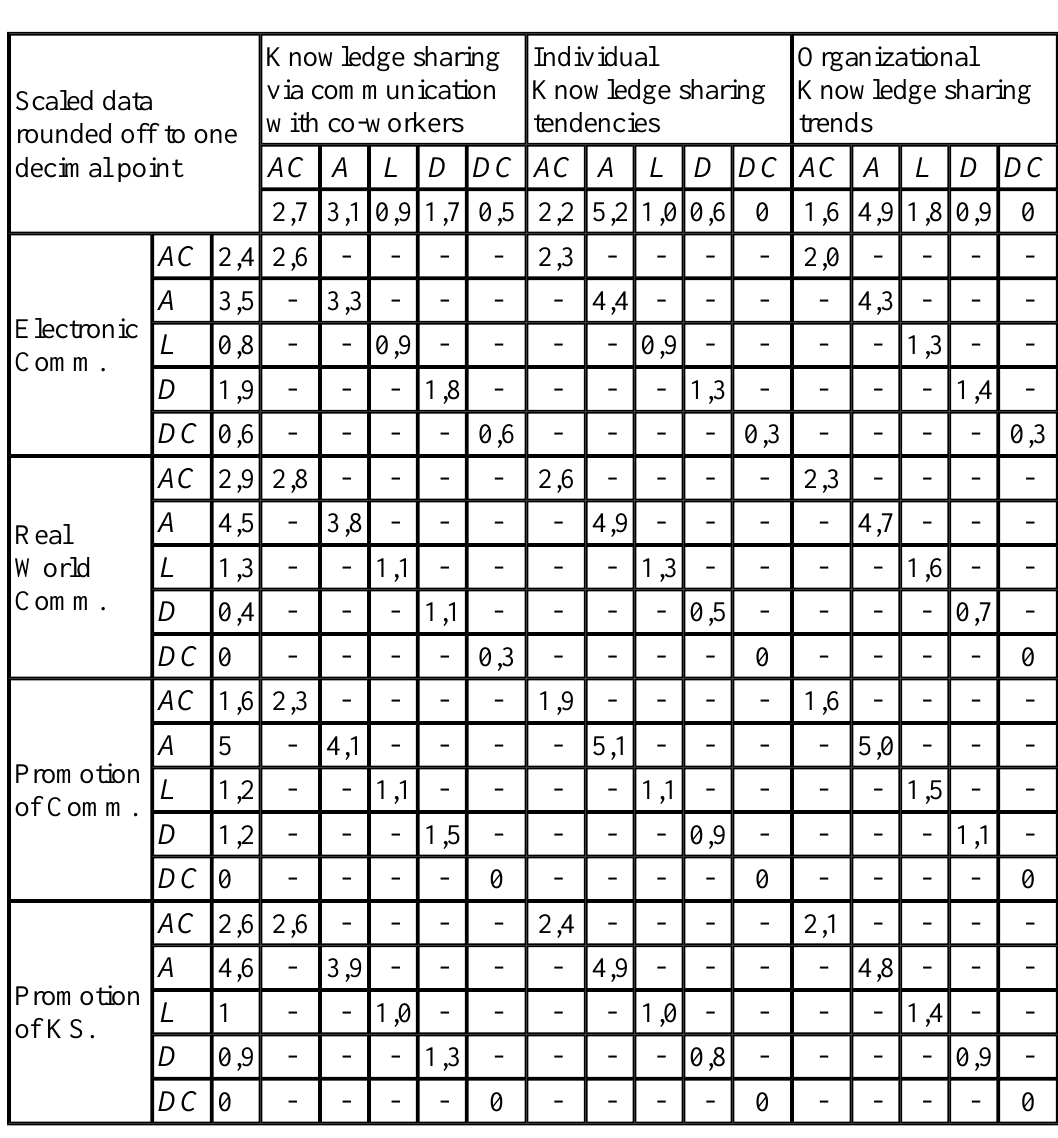
Table 2 Analytical matrix - averaged frequencies of grouped knowledge sharing